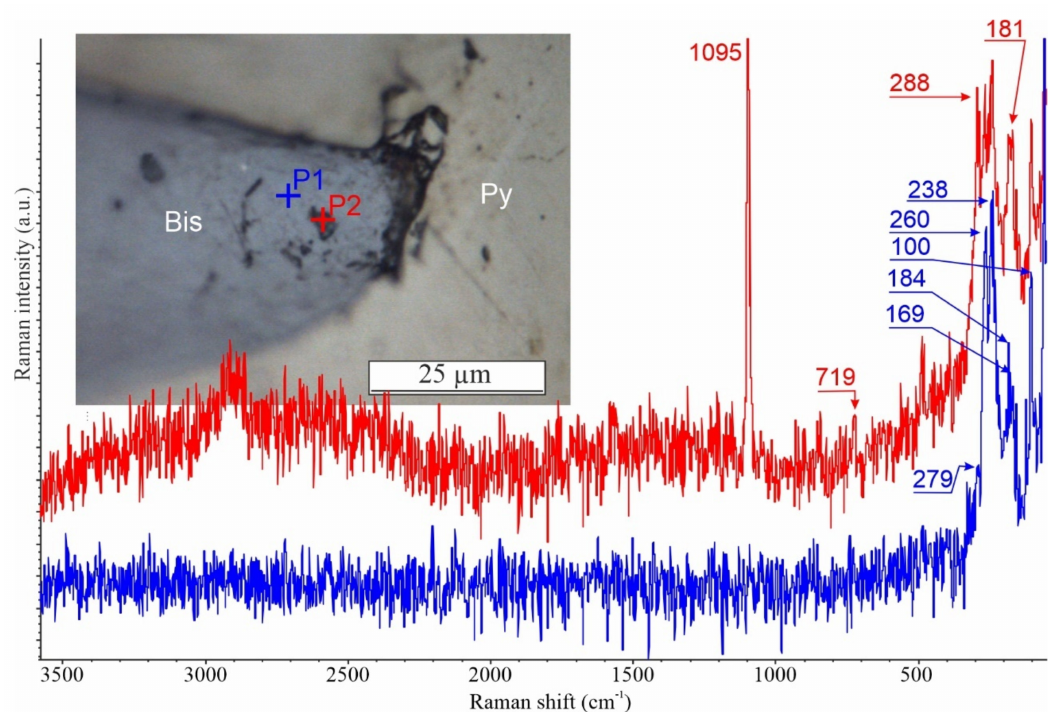
Figure 3. Raman spectra of bismuthinite inclusion in Py-I (blue line) with inclusions of bastnaesite-(Ce) (red line).